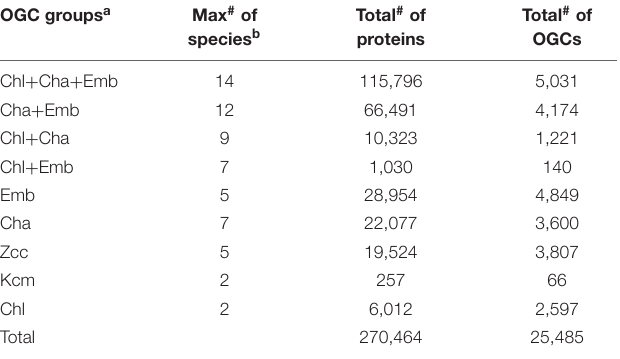
TABLE 3 | Classification of orthologous gene clusters (OGCs) into nine groups. OGC groups